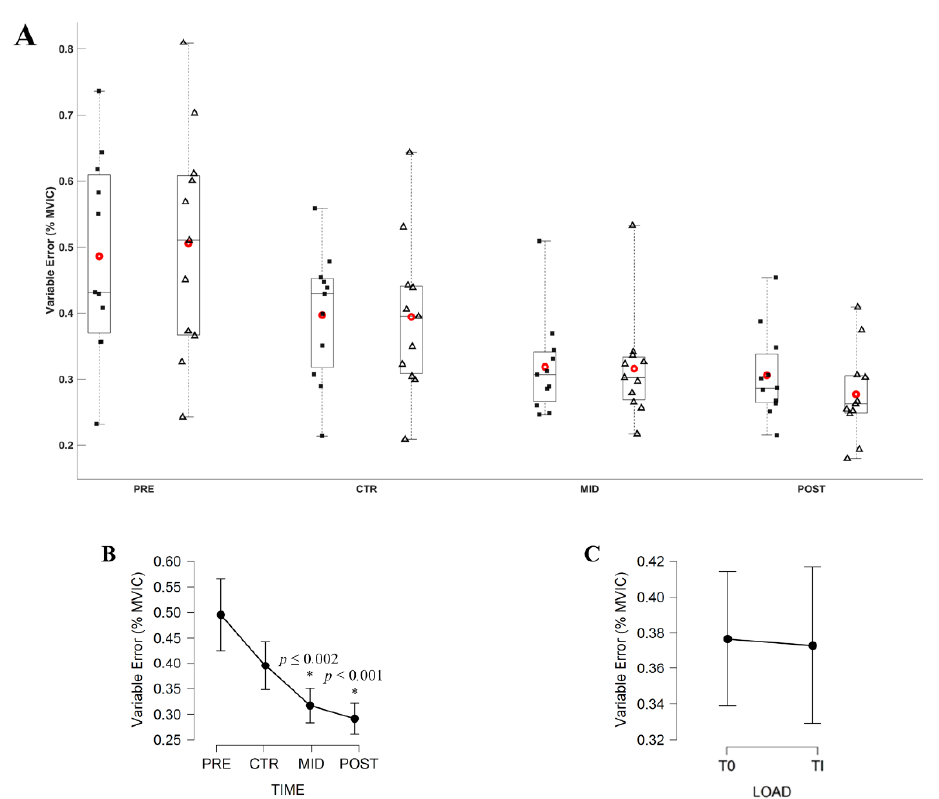
Figure 6. ( A ) Variable Error (VE; % MVIC) during submaximal contractions computed according to the torque levels, T 0 (black square) and Ti (white triangle), and evaluation sessions (PRE, CTR, MID, POST sessions). Each whiskers box indicates the mean (red circle) and the median (horizontal line). The inferior and superior edges of the box indicate the 25th and 75th percentile, respectively. Black dots represent individual participant performance. ( B ) VE during submaximal contractions computed according to evaluation sessions and ( C ) to the torque levels. Error bars represent the most extreme and non-outlier data points ( A ) and 95% confidence intervals ( B , C ). * Significantly different from PRE and CTR evaluation.